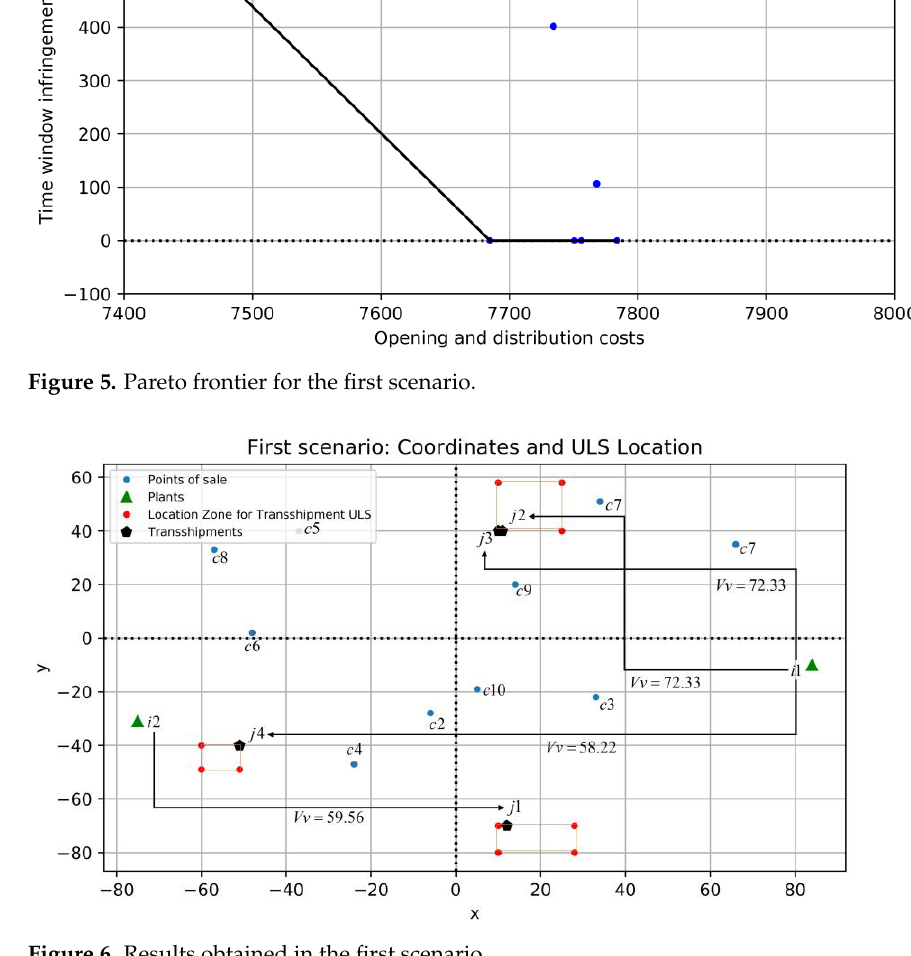
Figure 6. Results obtained in the first scenario.